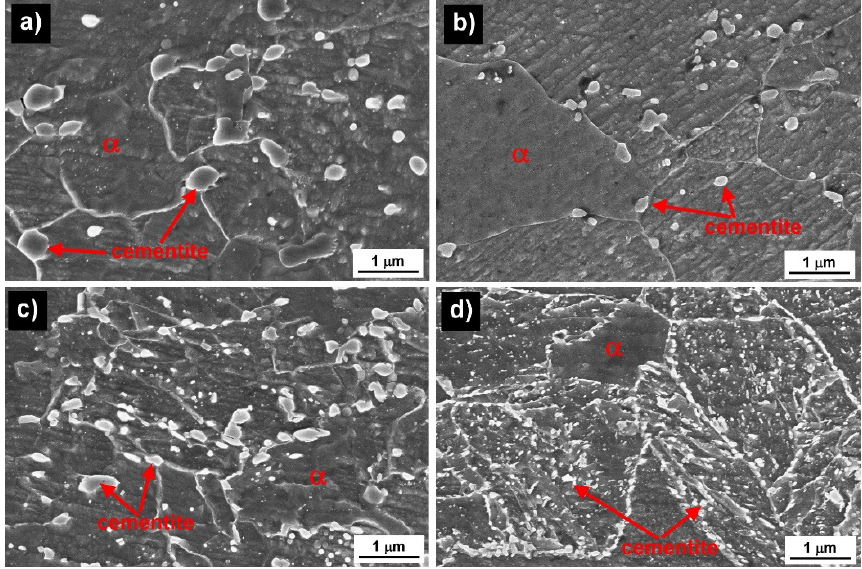
Figure 7. Detailed microstructure showing tempering of martensite islands in DP980 steel: ( a ) slow heating and isothermally treated for 3600 s at 700 °C, ( b ) slow heating followed by rapid cooling, and rapid tempering obtained from “X” location at the SC-HAZ of ( c ) GMAW and ( d ) RSW.